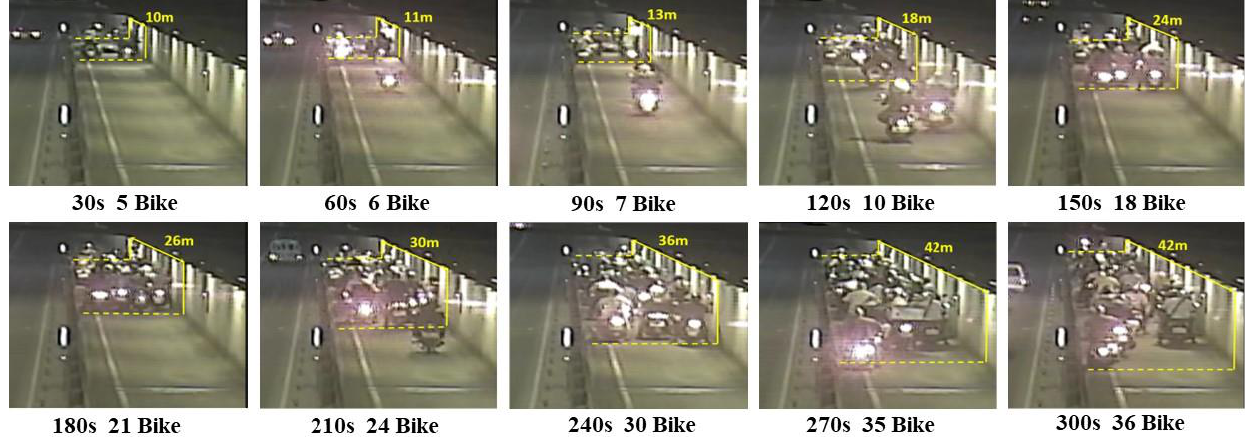
Figure 5. Screenshot of a real traffic accident in the motorbike lane (data source: Taiwan).